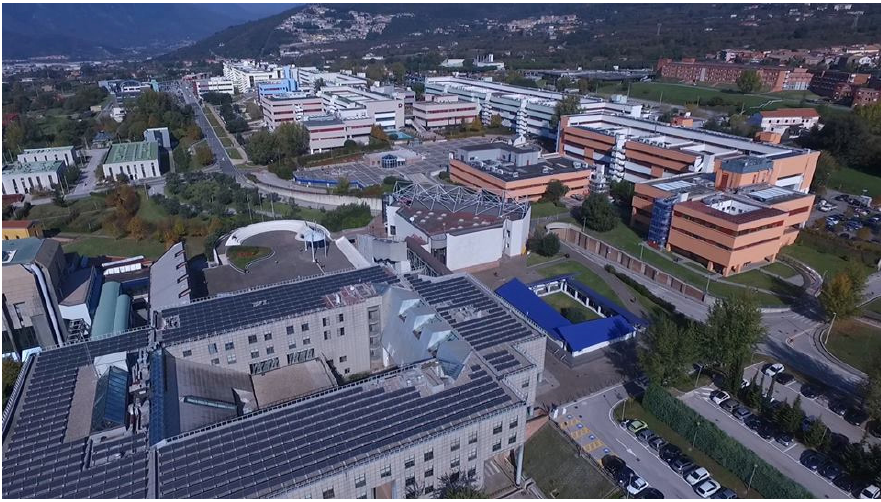
Figure 2. Campus of Fisciano